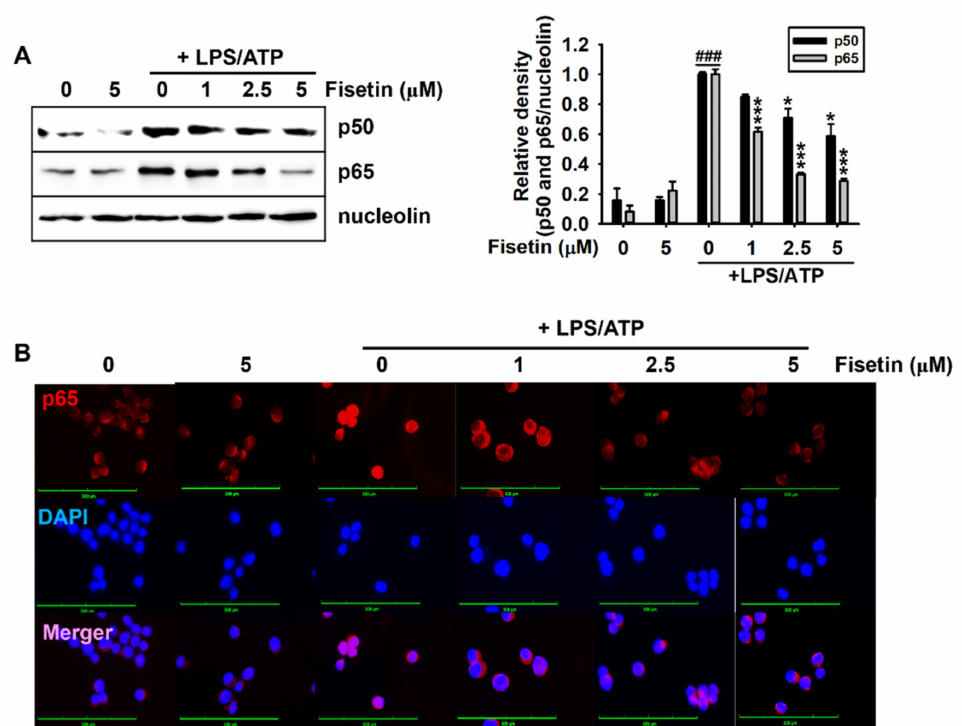
Figure 3. Fisetin inhibits the nuclear translocation of NF- κ B. BV2 microglial cells were treated with the indicated con- centrations of fisetin (0–5 µ M) for 2 h and subsequently stimulated with 1 µ g/mL LPS for 2 h, followed by stimulation with 1 mM ATP (LPS/ATP). ( A ) Nuclear proteins were extracted after 1 h of treatment with ATP and western blotting was performed. Nucleolin was used as a loading control. Relative densities of p50 and p65 were calculated using ImageJ software. ( B ) In a parallel experiment, the cells were fixed with 4% paraformaldehyde and immunostained for p65 with Alexa Fluor 647-conjugated secondary antibody. The images of the cells were captured using a CELENA S Digital Imaging System. The results indicate the mean ± standard error median (SEM), and is representative of the results obtained from three independent experiments. ### p < 0.001 vs. untreated cells; *** p < 0.001 and * p < 0.05 vs. LPS/ATP-treated